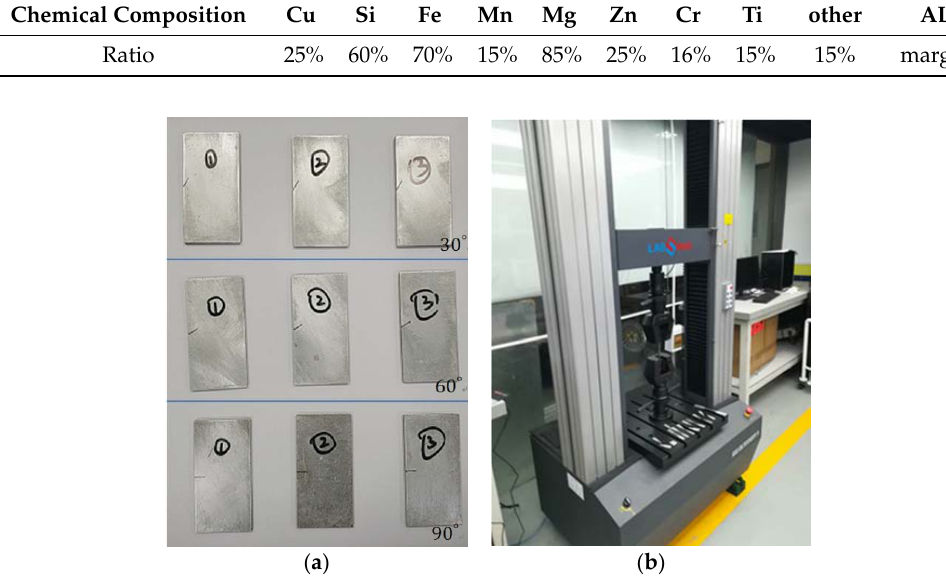
Figure 11. Samples and Universal Hydraulic Testing Machine. ( a ) Three groups samples; ( b ) Universal Hydraulic Testing Machine.